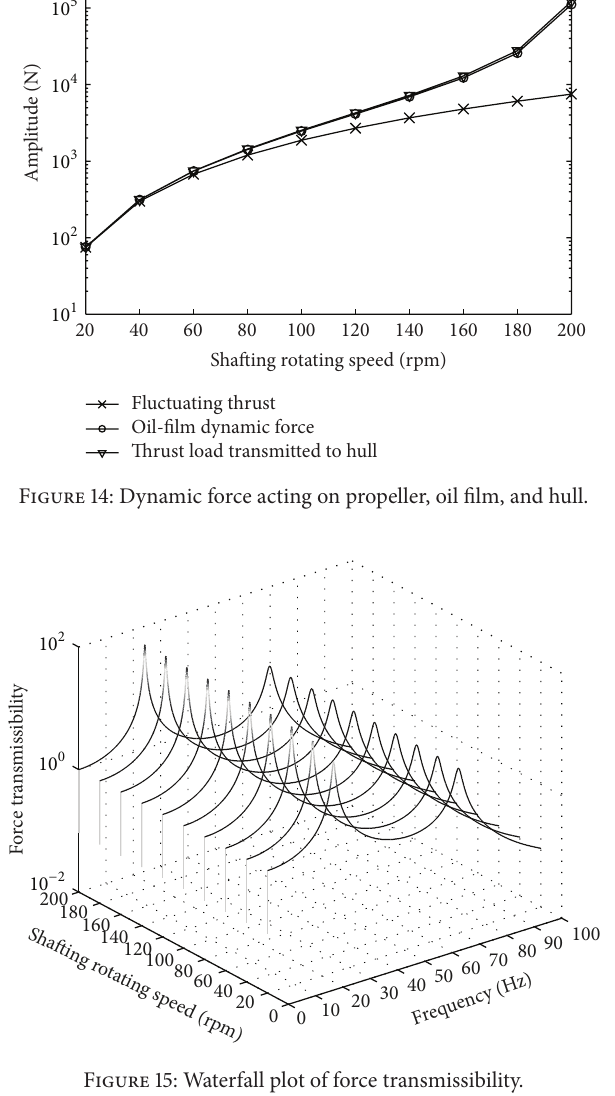
Figure 15: Waterfall plot of force transmissibility.